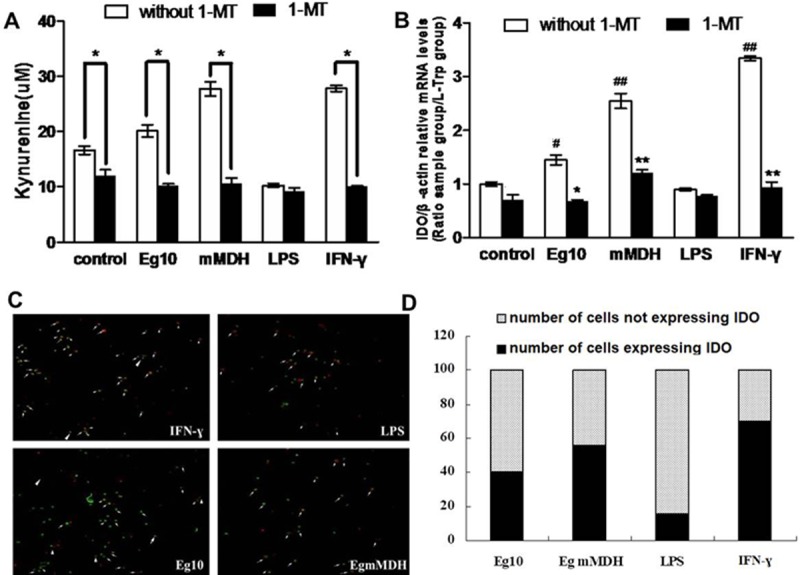
Expression of IDO in antigen-treated DCs.At 7d, each BMDC treatment group in experiment (2) was collected. (A). the kynurenine content in the supernatant was measured by ELISA. The numbers in Y-axis indicate the range of concentrations of kynurenine in the supernatant. Bars represent means ± SEM. (B). The mRNA content of IDO in each treatment group was detected by real time qPCR. The experiment was performed in triplicate and the mean values were reported. Bars represent means ± SEM. (C).Double label fluorescence immunohistochemistry staining and confocal laser scanning microscope showed IDO expression in different group. Under fluorescence microscopy, IDO was stained with red, the cell nucleus was stained as green with CFSE. The white arrows in the figures represent the cells expression IDO. (D). The ratio of IDO+DC/IDO–DC in different groups: ▓ indicates number of cells not expressing IDO; ◼indicates number of cells expressing IDO. Control means DCs are in RPMI1640 culture medium. #
P<0.05 and ##
P<0.01, significantly different from the control group. *P<0.05 and **P<0.01, significantly different from the group in the absence of 1-MT.